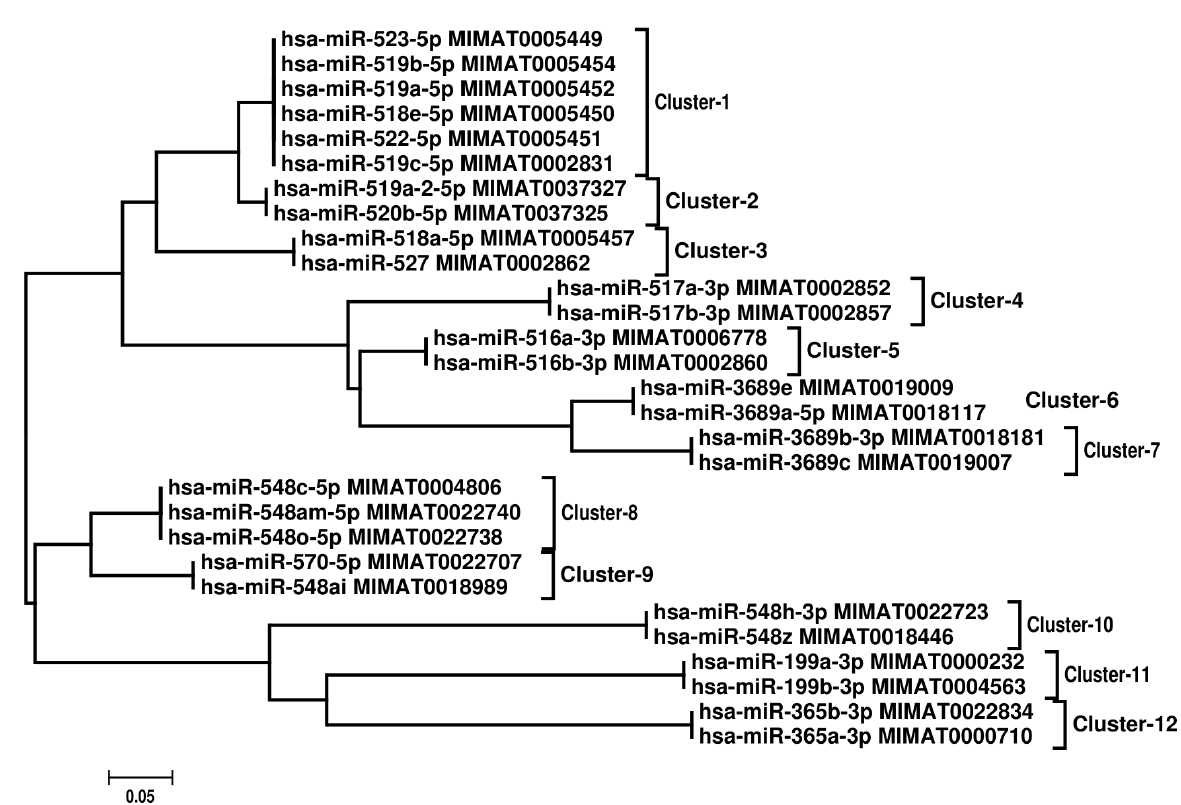
Figure 1. Shows evolutionary relationships of taxa for all mature miRNAs in Homo sapiens . The analysis involved 29 nucleotide